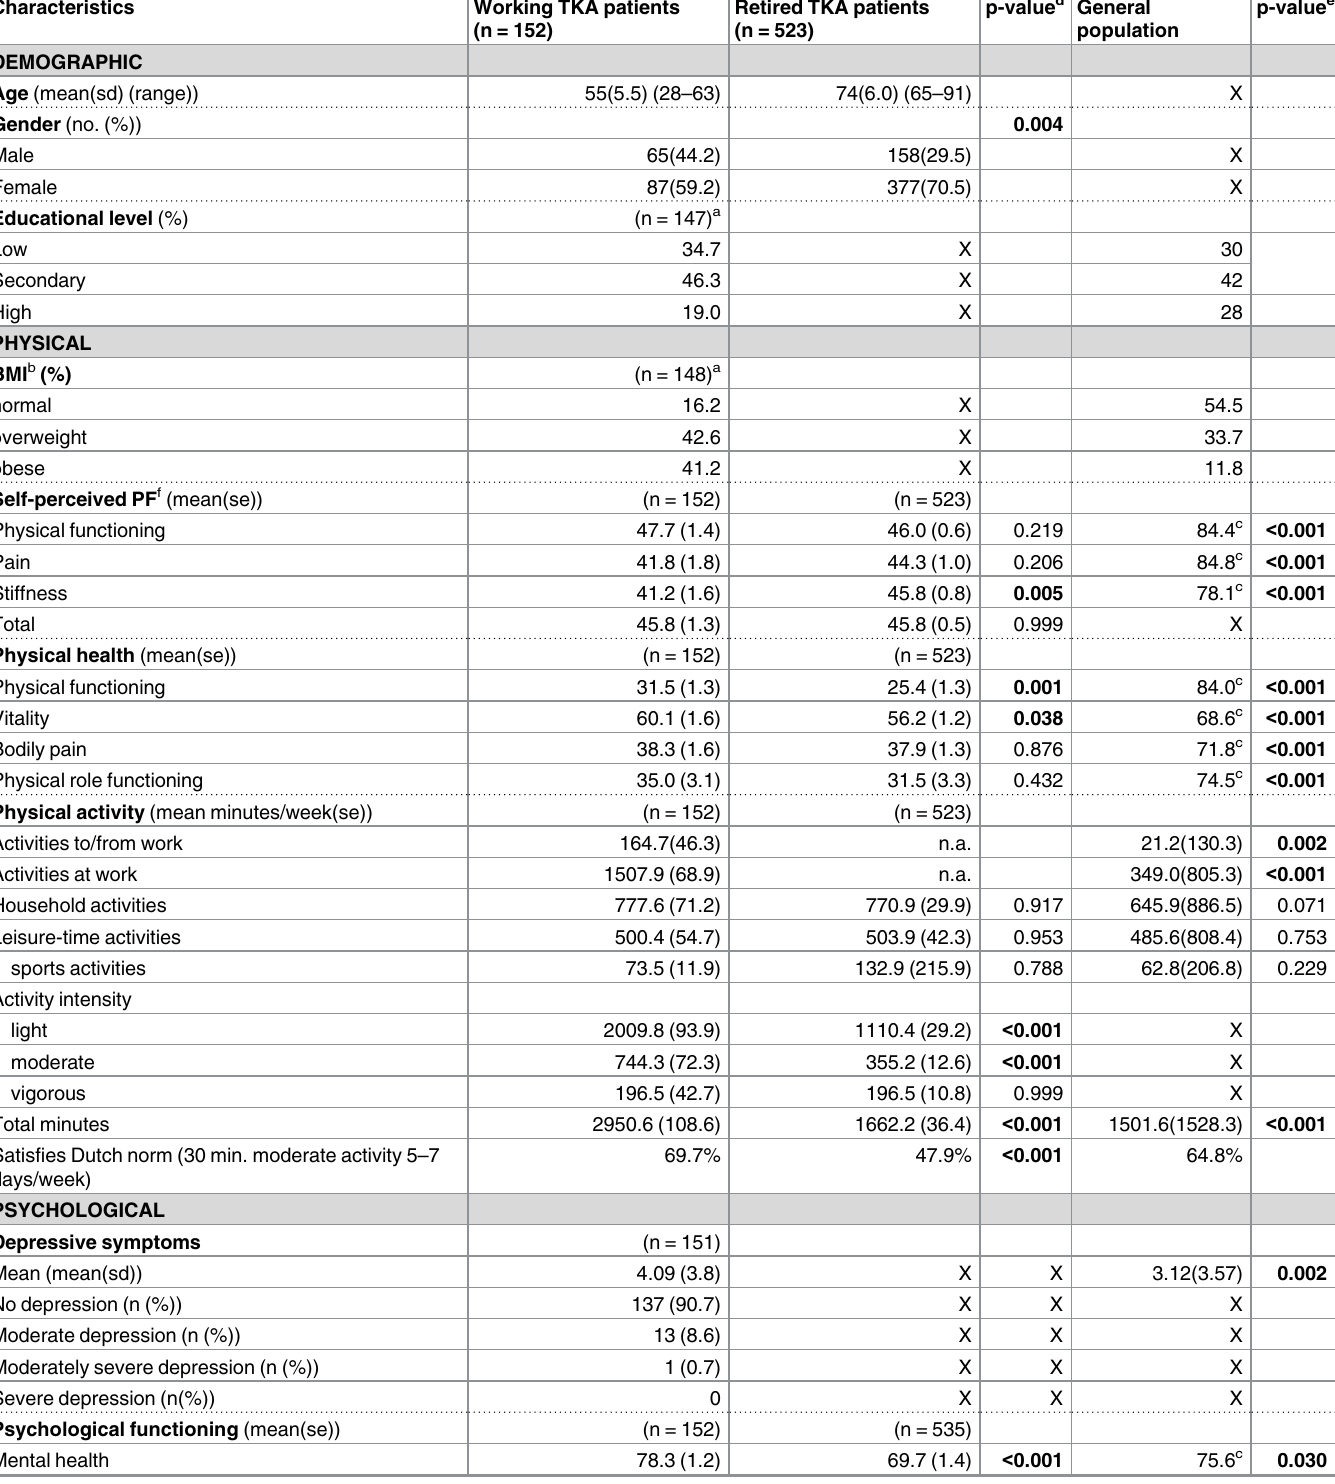
Table 2. Demographic, physical, psychological and social characteristics of working TKA patients compared with retired TKA patients and the general